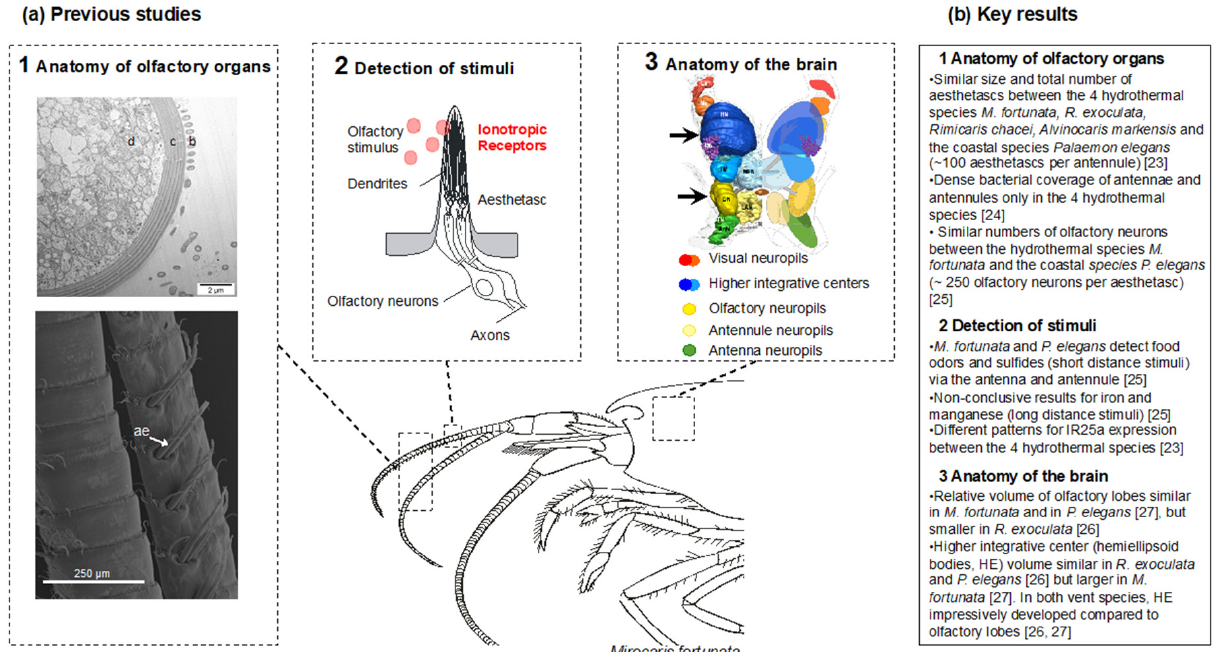
Figure 1. State of the art on hydrothermal shrimp olfaction. ( a ) Previous studies conducted by our team on olfaction in hydrothermal shrimp are summarized in this figure. Panel 1 shows the anatomy and ultrastructure of the olfactory organs of M. fortunata . The lower image shows the antennule, which consists of a median flagellum ( left ) and a lateral flagellum with aesthetasc sensilla ( right ). The upper image shows a cross section of an aesthetasc with the cuticle (c), bacteria (b) on the outer surface and dendritic segments (d) of olfactory neurons inside. Panel 2 shows a scheme of an aesthetasc sensilla from a marine crustacean decapod. Detection of various ecologically relevant chemical stimuli (at short and long range) by the antennal appendages was measured by electroantennography. Several ionotropic receptors, including the IR25a co-receptor putatively involved in olfaction, were identified and shown to be mainly expressed in the lateral flagellum of the antennules bearing the aesthetascs. Panel 3 shows a schematic representation of the organization of crustacean brain in dorsal view. Olfactory neuropils (black arrow) receive the sensory input from olfactory neurons that innervate the aesthetasc sensilla. ( b ) Key results from studies on olfactory organs anatomy and stimuli detection [23–25], and on brain anatomy